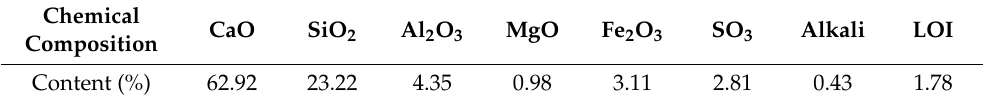
Table 1. The chemical composition of